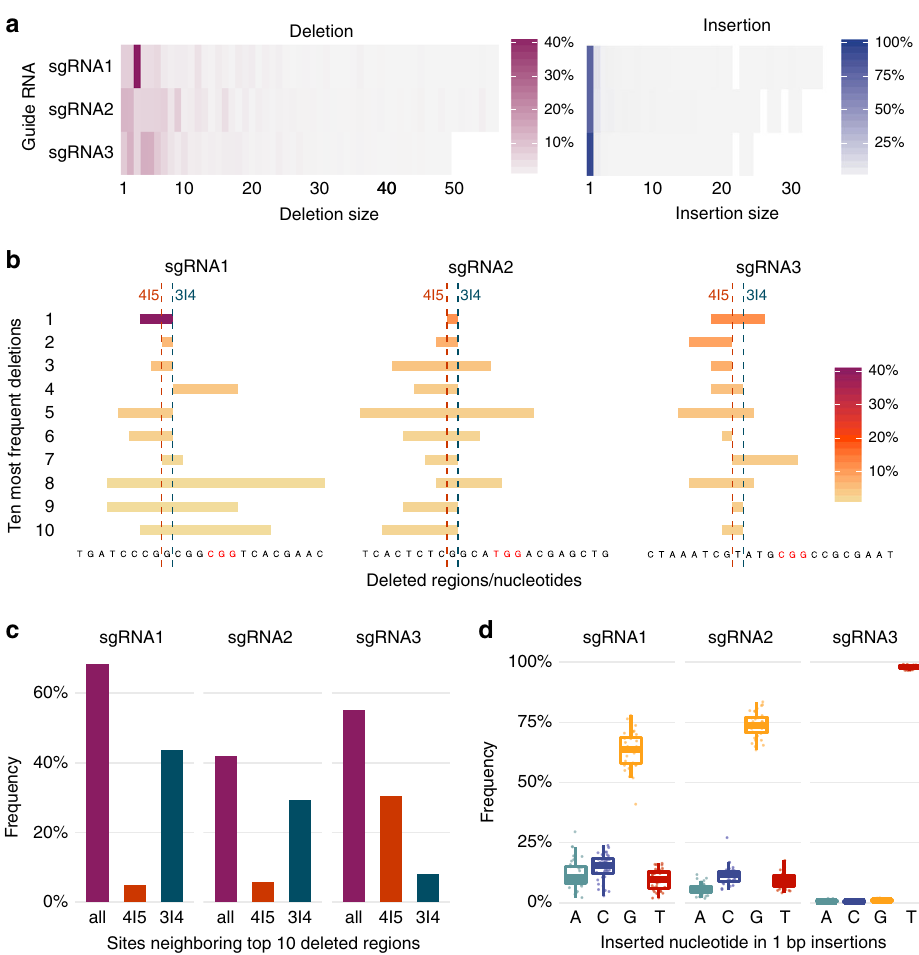
Fig. 4 Mutation patterns induced by Cas9 in the 36-integration TRIP cell line. a Observed deletion and insertion sizes. Heatmaps show the overall frequency (color gradient) of deletions (red, left) and insertions (blue, right) per size (horizontal axis) for each guide RNA (vertical axis) in the TRIP cell line. b Deletion patterns and positions. Shown for each guide RNA are the ten most frequent deletion patterns with respect to the non-target DNA, from top to bottom in decreasing order of frequency. Each horizontal bar indicates the position of a deletion pattern, and corresponding non-target DNA sequence lost (at the bottom), colored according to frequency. Expected 3|4 and alternative 4|5 break sites are indicated by two vertical dashed lines. c Frequency of sites neighboring the ten most frequently deleted regions for each guide RNA, shown in Fig. 3b. Three vertical bars indicate the proportion of: all such deletions regardless of neighboring site (all, red), the subset of those deletions neighboring the expected break site (3|4, green), or the subset of those deletions neighboring the alternative break site (4|5, orange). For deletions with ambiguous positions, we weighted the frequencies by the ratio of positions meeting the criteria. We observed similar trends using all data. d Frequency of each nucleotide in 1-bp insertions. For each guide RNA, boxplots show the frequency (vertical axis) of insertions of each nucleotide (horizontal axis and color) across the 36 IRs (dots). Boxes show the median, fi rst and third quartiles of the frequency distributions; whiskers extend to 1.5 times the inter-quartile range from the top and bottom of the box. Source data